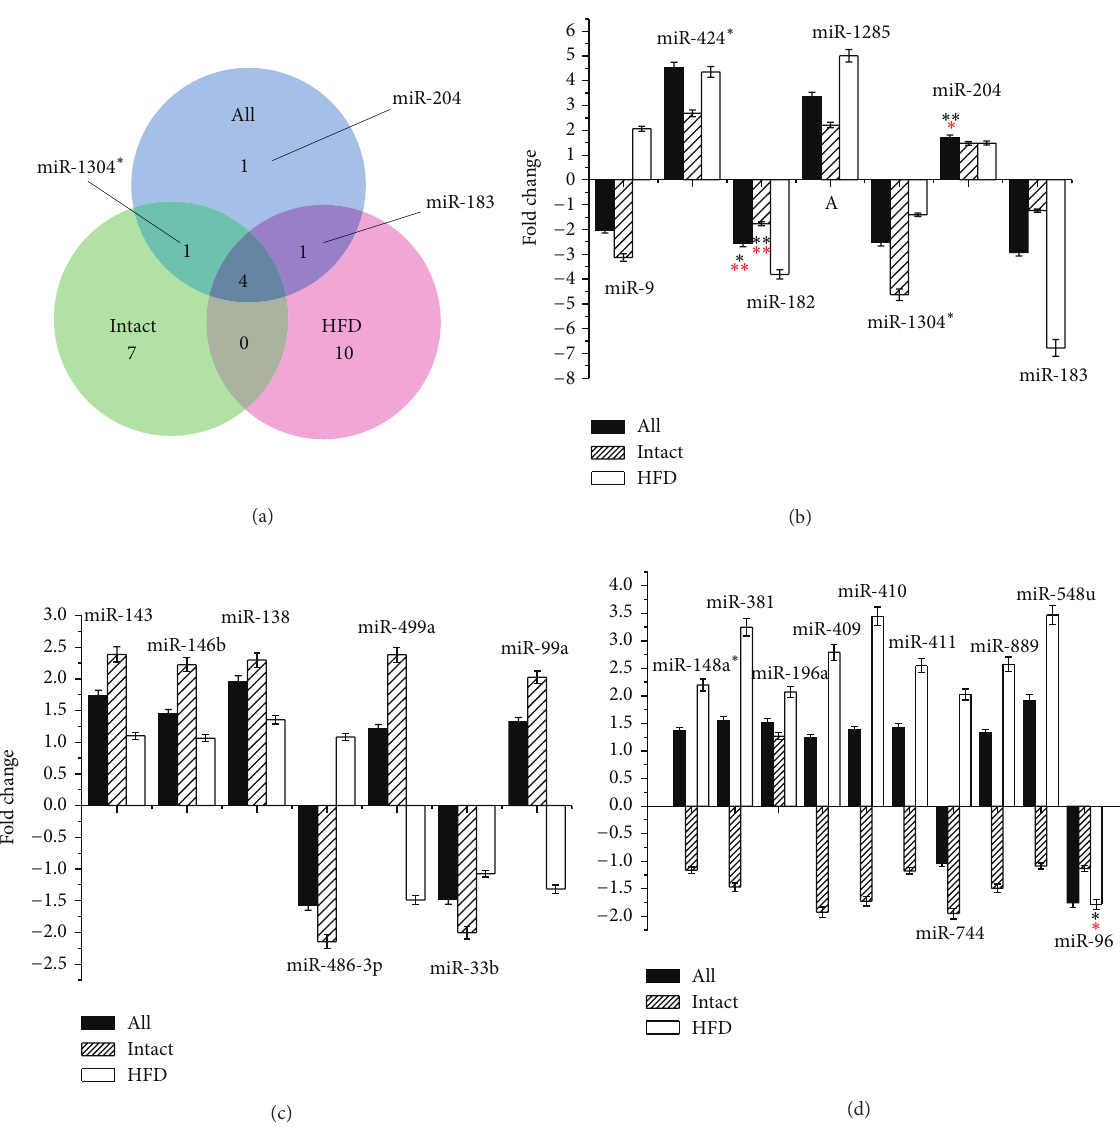
Figure 1: The general expression tendencies of the 24 specific miRNAs in All comparison, intact comparison, and HFD comparisongroups. The comparisons were carried out following the criteria where T2D individuals were compared with no-T2D individuals. All comparisons were carried out in all the monkeys without considering the diet conditions, while intact comparison was only in intact monkeys and HFD comparison was in HFD monkeys. (a) The Venn diagram represents the numbers of differential expressed miRNAs in All comparison (blue), intact comparison (green), and HFD comparison (red) groups. (b) The 7 specific miRNAs in the All comparison groups. All the miRNAs are in the same expression tendencies except miR-9. The positive values of the fold change mean that the miRNAs are upregulated in the T2D samples, whereas the negative values mean the downregulated expression. (c) The specific 7 miRNAs uniquely existed in the intact comparison group. Without miR-486-3p, miR-499a, and miR-99a in inconsistent expression between intact and HFD groups, others are in the same expression tendencies. (d) The 10 specific miRNAs uniquely existed in the HFD group. All of the miRNAs, except miR-196a and miR-96, are in inconsistent expression tendencies between the intact and HFD induced groups. Statistically significant differences are tested at 𝑃 < 0.05 significance. The significance in 𝑡 -test was labeled in black color, whilst that in ANOVA test was in red color ( 𝑃 ∗ < 0.05 , 𝑃 ∗∗ < 0.01